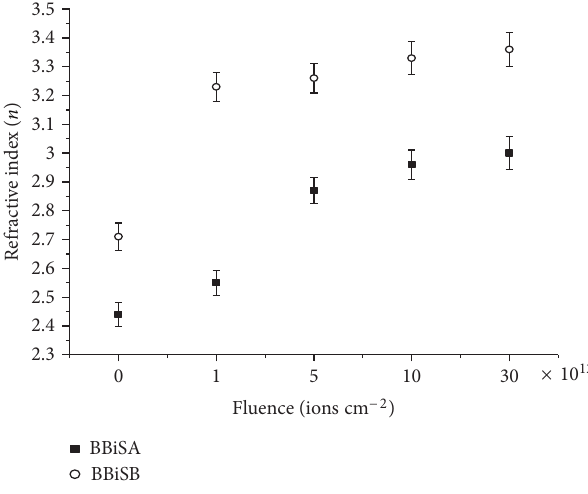
-irradiated samples for 14+